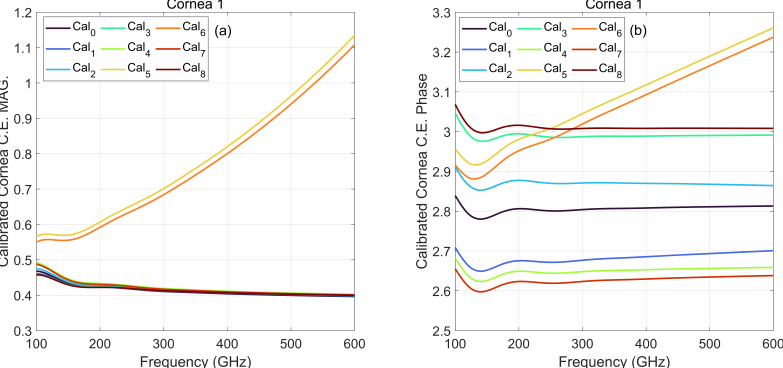
Figure 4. ( a ) Magnitude and ( b ) phase of cornea 1 calibrated by 8 different perturbation scenarios compared to correctly calibrated cornea, Cal 0 , at frequency range of 100–600